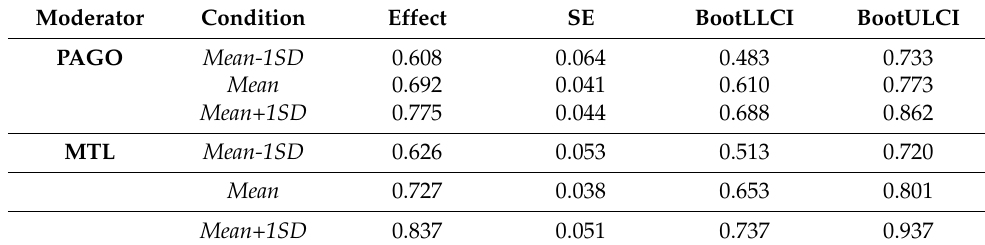
Table 4. Moderated Mediating Effect of Machiavellianism by PAGO/MTL.